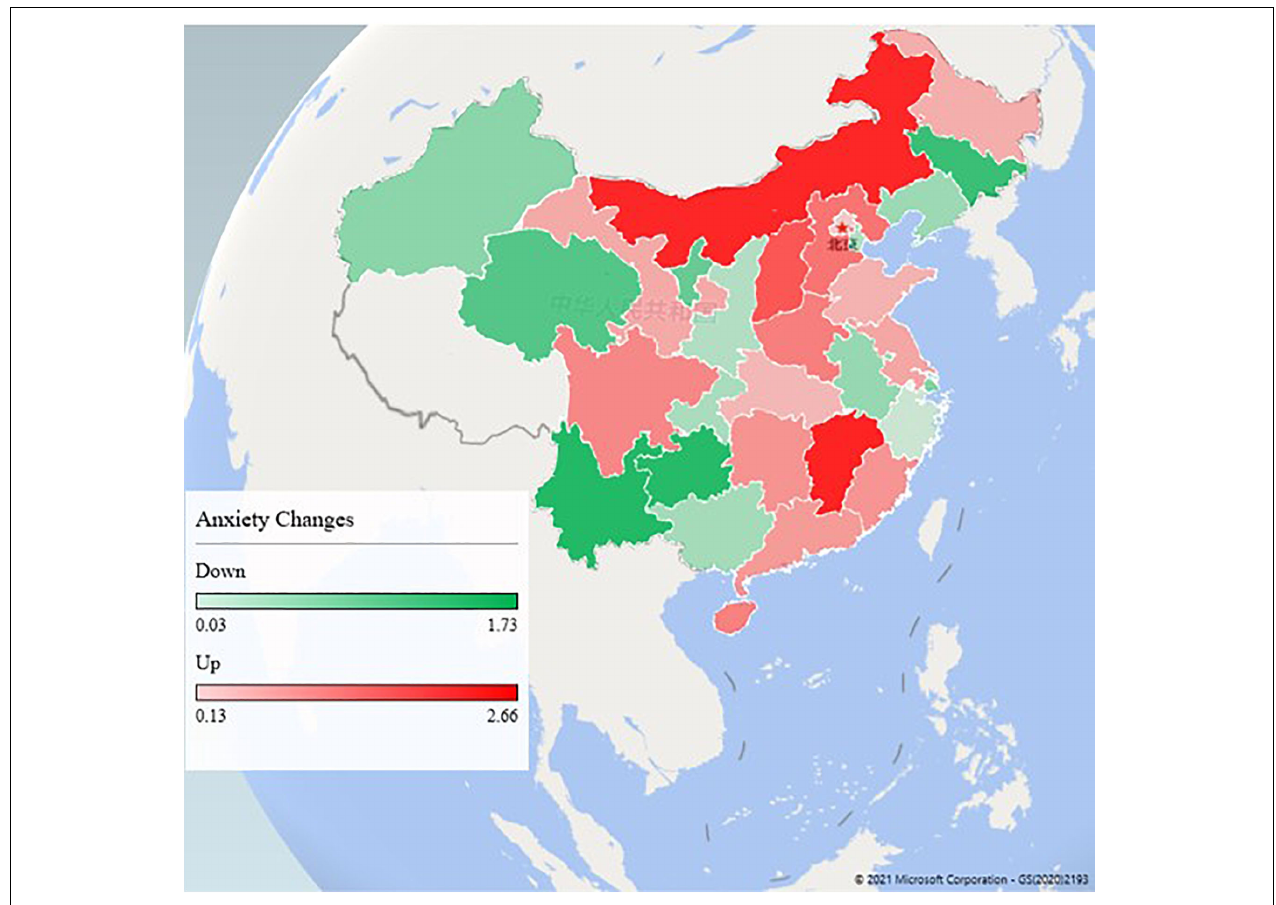
FIGURE 3 | The change of anxiety from early outbreak stage to under controlled stage in different provinces in China.